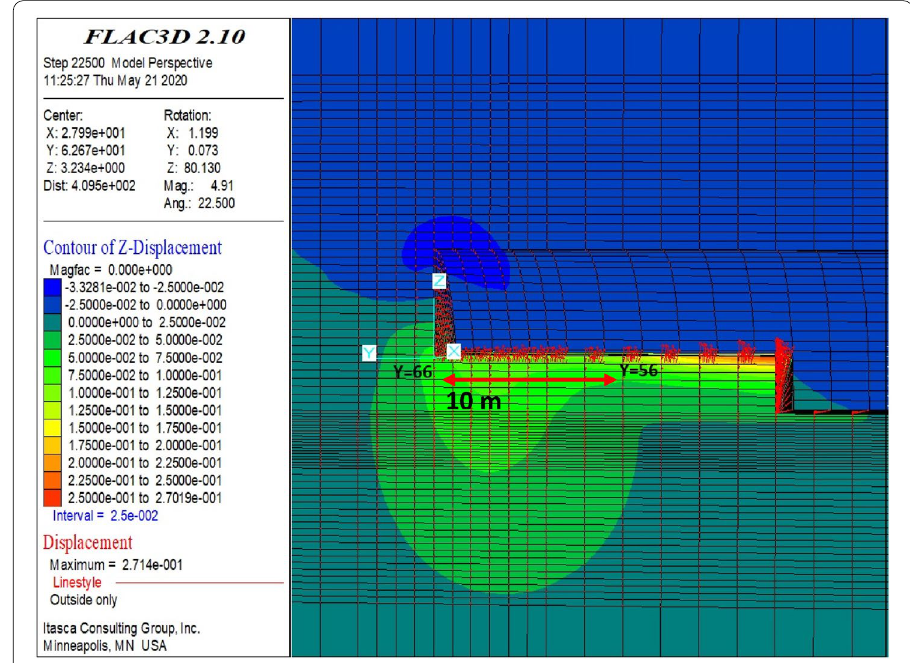
Fig. 22 Swelling at the top heading section in the Z direction (without umbrella and forepoling)